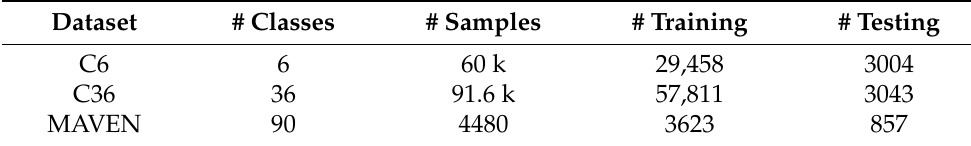
Table 1. Dataset